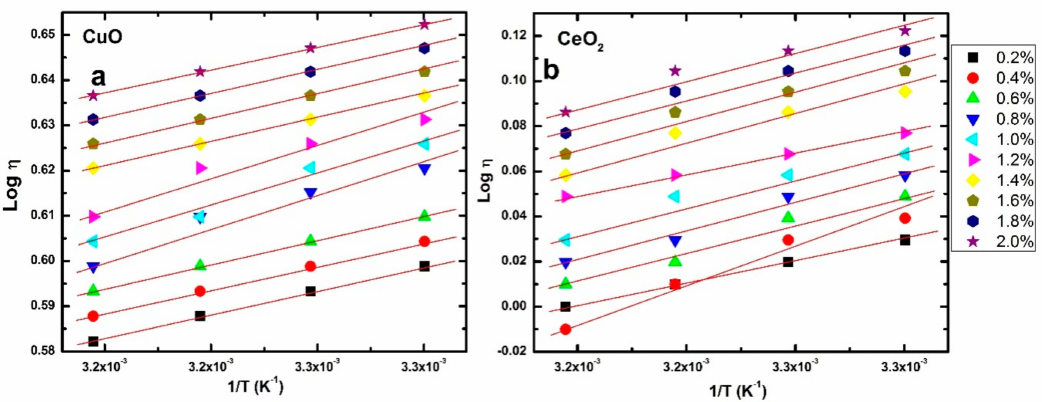
Figure 3. Variation of 1 / T against Log η for ( a ) CuO NFs and ( b ) CeO 2